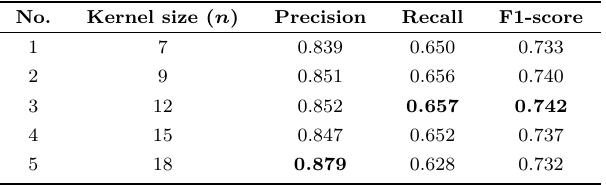
Table 3 Performance of SpinNet when using different size of strip- shaped large kernel in spinning convolution. The size of the kernel we use is 1 × n . The experiment reveals that too long or too short kernels harm the performance, and a 1 × 12 kernel is most appropriate for our task